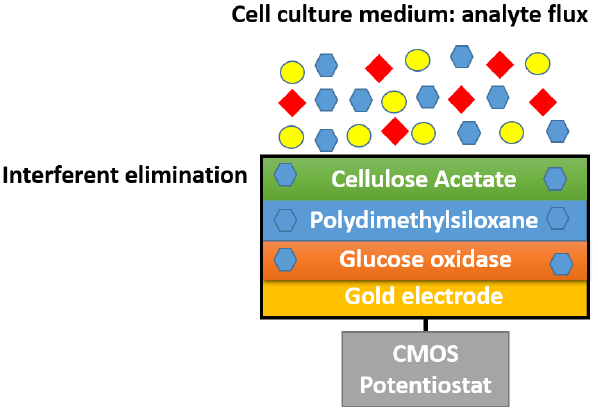
Figure 5. Electrochemical measurement setup for glucose sensing, comprising multi-layer membrane and CMOS potentiostat.